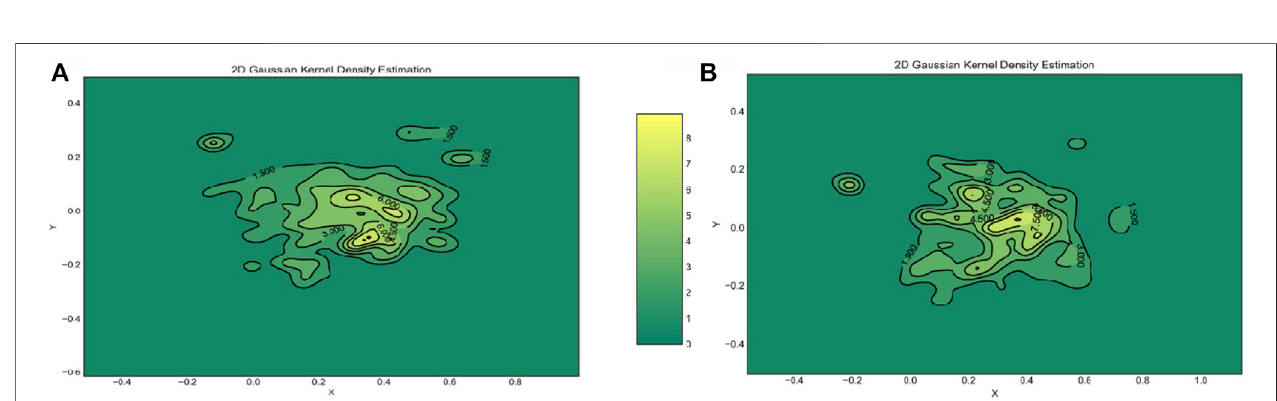
FIGURE12| Plotoftheprobabilitydistribution functionusingaGaussian2DKDE. (PanelA) showsthedensity surfacefortherightarm oftheparticipants. (Panel B) shows the density surface for the left arm of the participants. Figure changed to 2D plot with color gradient instead of 3D.